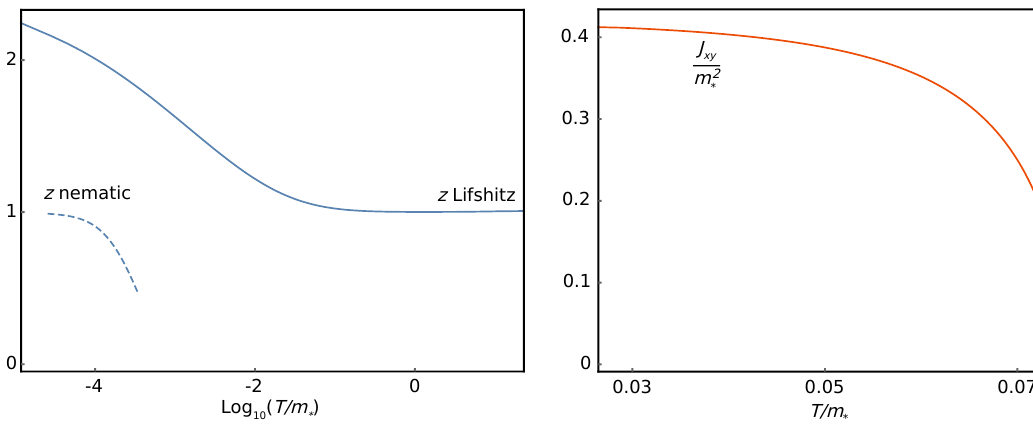
Figure 5 . Left: dynamical critical exponent for the Lifshitz and nematic phases as a function of the temperature defined as z ≡ 2 S/TS 0 . The curves correspond to the q = 2 solution. Right: order parameter J xy , defined as the subleading term in the near boundary expansion of Q 2 , as a function of the